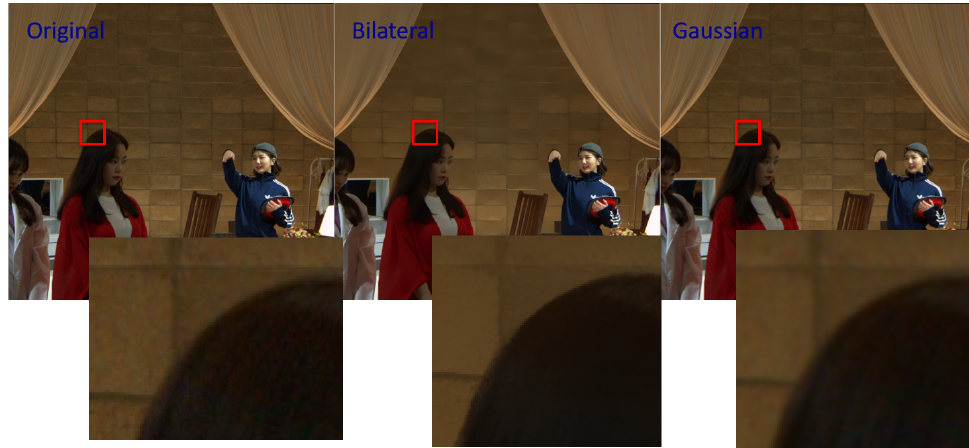
Figure 10. The bilateral filter preserves the high frequency components of the images. The depth map and the Delaunay triangles are combined to generate the 3D mesh. The third coordinate (depth information) is added to the generated triangles defined in the 2D coordinates so that the 3D mesh can be constructed (Figure 12).